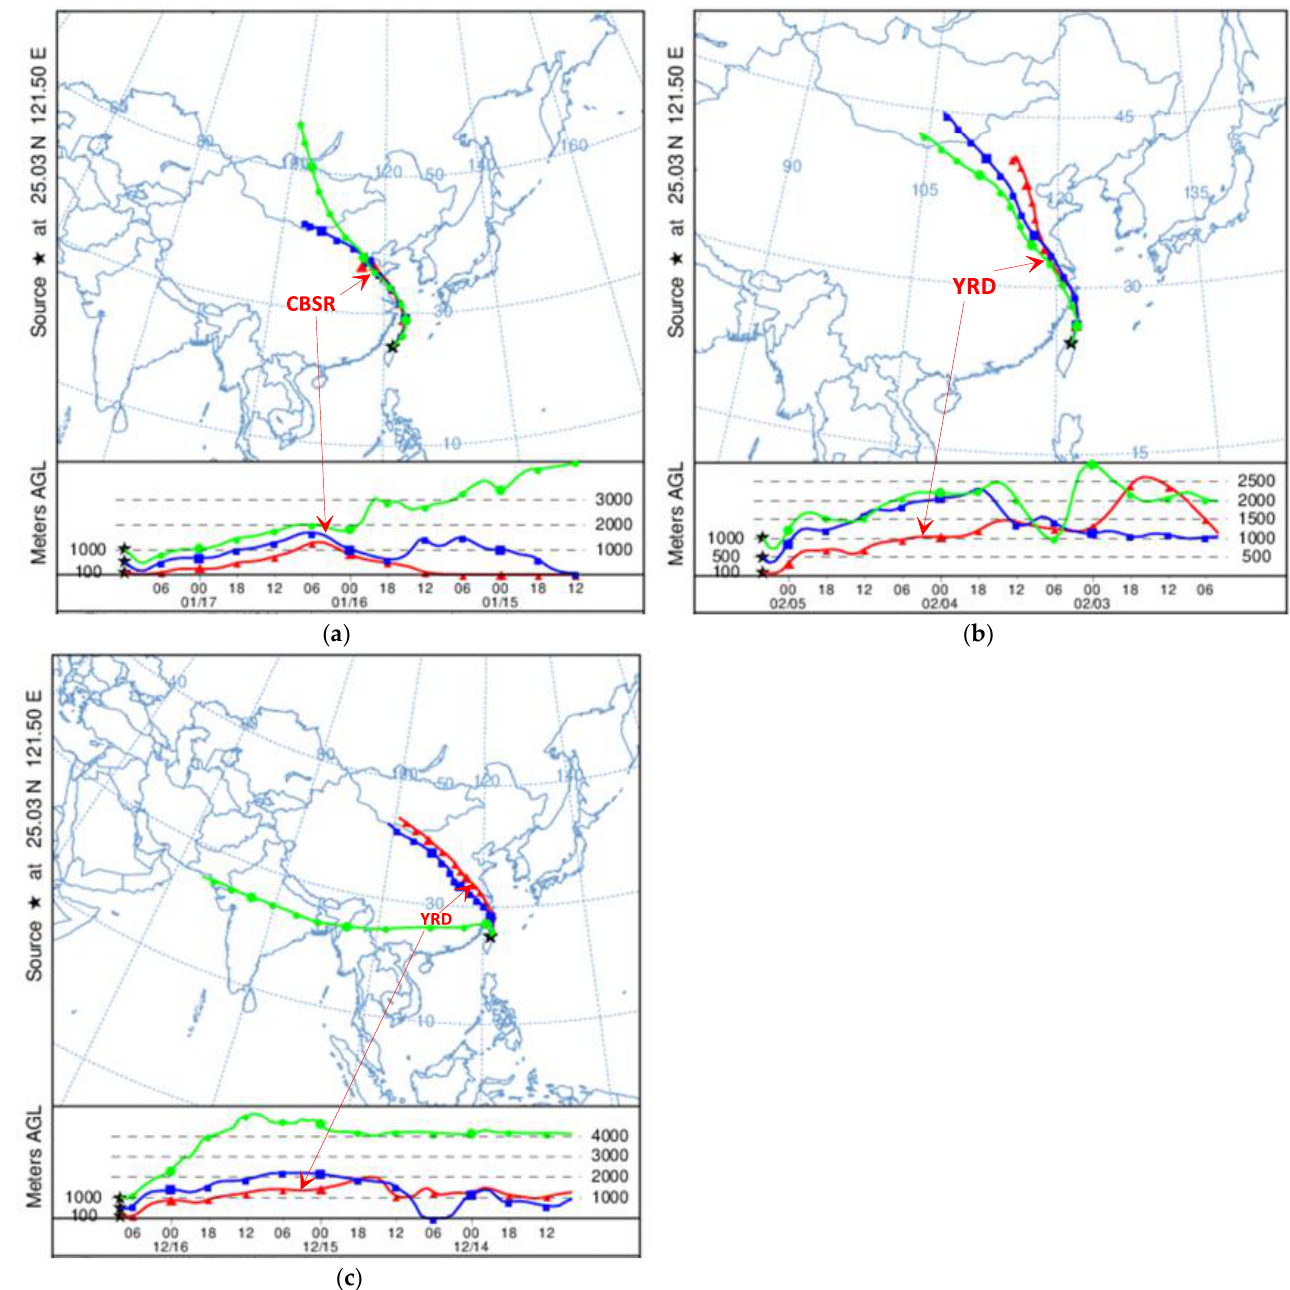
Figure 8. Back trajectory tracks run using NOAA HYSPLIT model, NASA/AERONET based on GDAS meteorological data of three PM 2.5 events at the Taipei station ending (maximum C PM in Taipei) at ( a ) 20:00 LST on 17 January 2015; ( b ) 12:00 LST on 5 February 2015; ( c ) 16:00 LST on 16 December 2015. Red line: 100 m-AGL; blue line: 500 m-AGL; green line: 1000